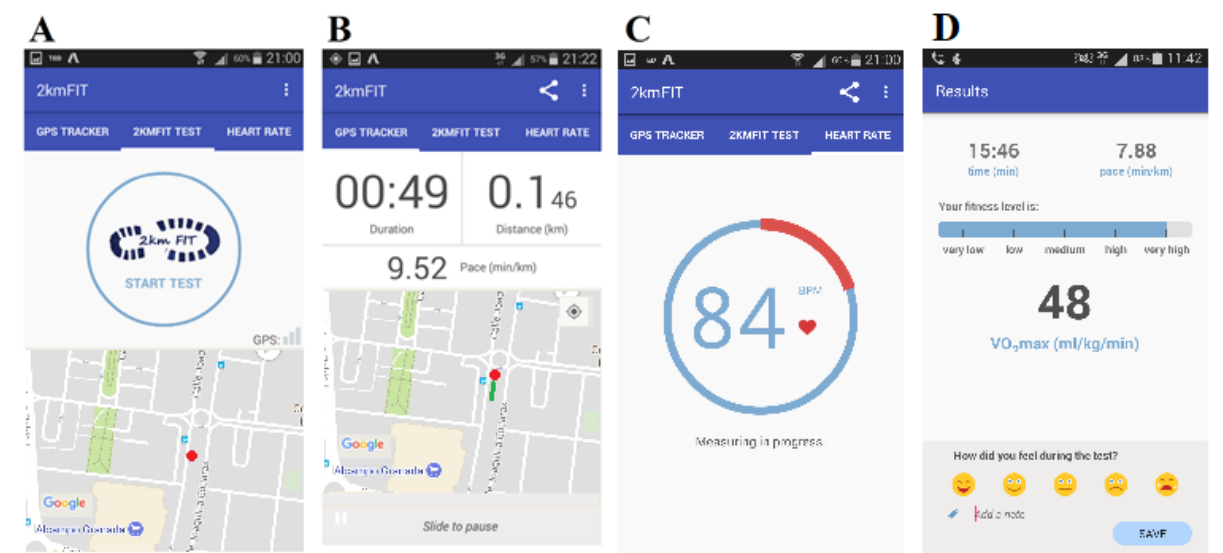
Figure 1. Main screens of the 2kmFIT-App Android